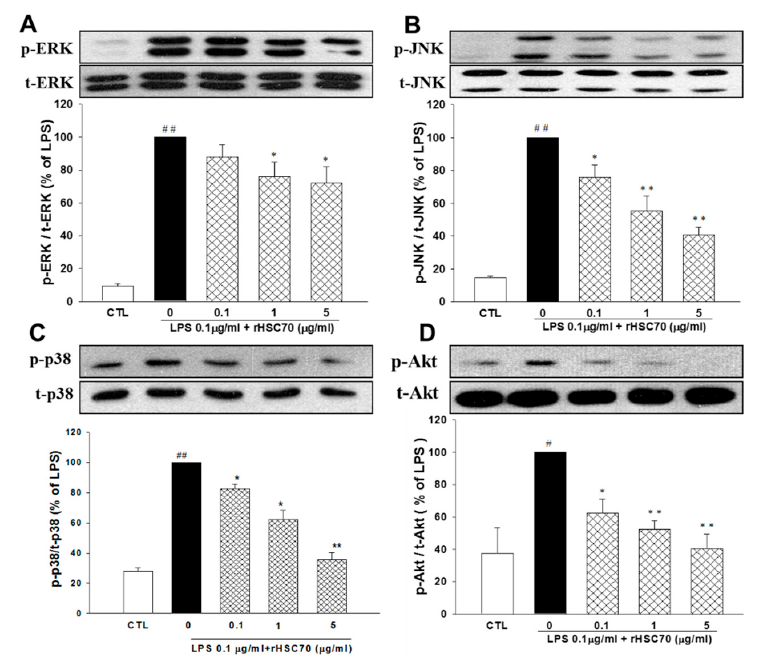
Figure 5. Effects of rHSC70 on LPS-induced activations of MAPKs and Akt pathways. Cells were pretreated with rHSC70 (0.1, 1 and 5 µg/mL) for 5 min before LPS treatment and protein samples were prepared 30 min after LPS treatment. Western blotting shows that rHSC70 attenuated LPS-induced phosphorylation of ERK 1/2 ( A ), JNK ( B ) and p38 ( C ) MAPK, and Akt ( D ). The total MAPK and Akt levels were used as internal controls. Significant differences were identified by One-Way ANOVA followed by Dunnett’s test. The results are reported as mean ± SEM of three independent experiments, with triplicate determinations in each experiment. # p < 0.05, ## p < 0.01 versus control group (CTL); * p < 0.05, ** p < 0.01 versus LPS group.